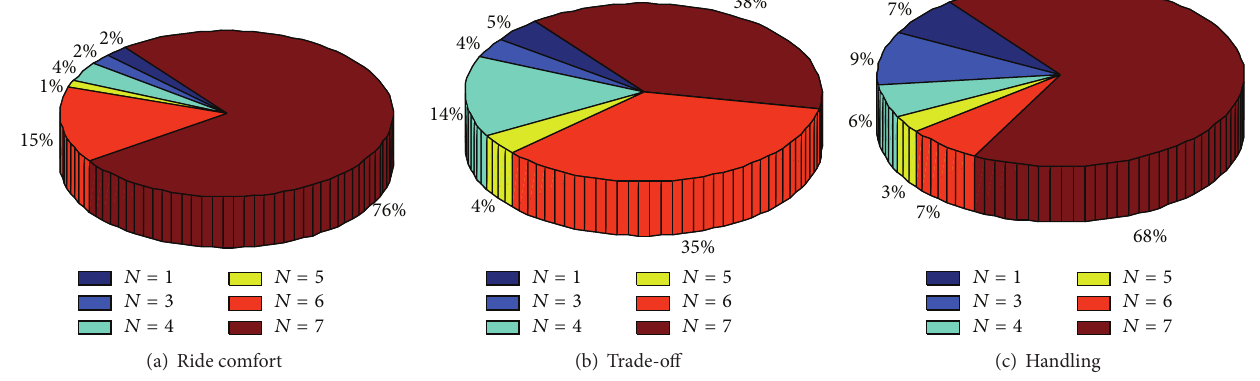
Figure 14: Probability of 𝑁 for